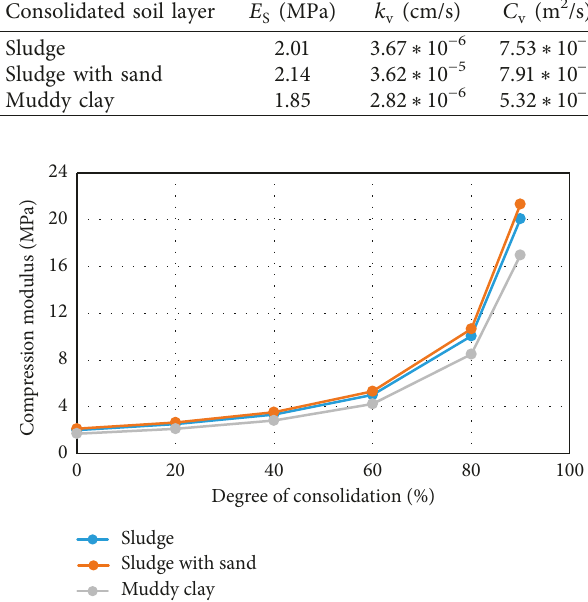
Figure 6: Change curve for the compressive modulus with degree of